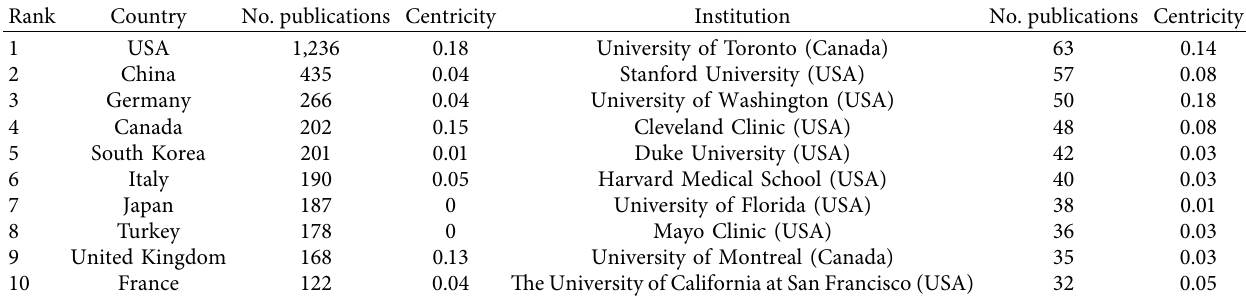
Table 1: Countries and institutions publishing the most articles about acute postsurgical pain, 2012–2021.